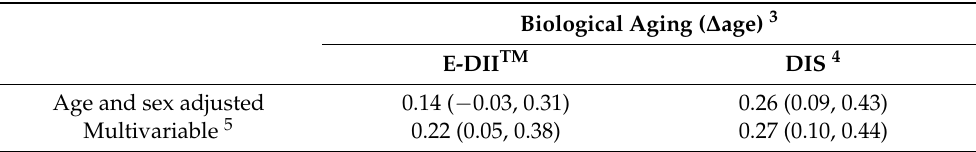
Table 2. Beta-coefficients 1 (95% CI) for biological aging ( ∆ age) according to the E-DII and DIS 2 , Moli-sani sub-cohort (n = 4510).